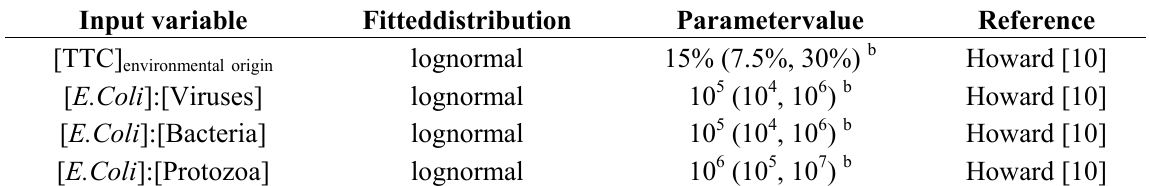
Table 1. Input parameters for exposure assessment for QMRA model.